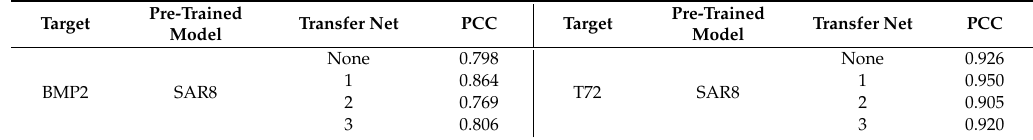
Table 14. Transferring performance of SAR8 / BMP2 / T7.